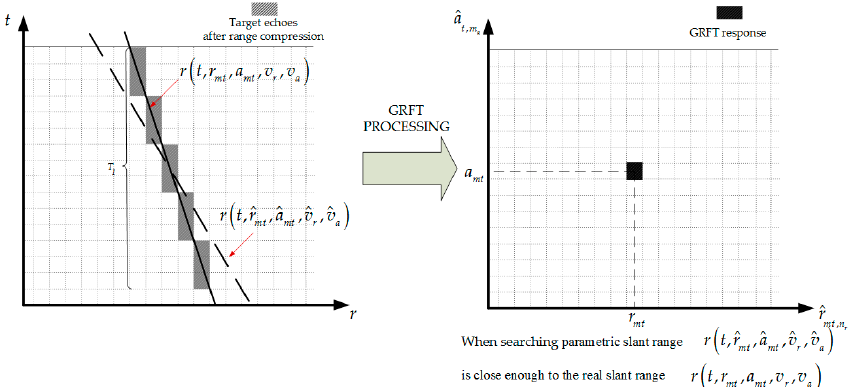
Figure 3. The schematic diagram of generalized Radon-Fourier transform (GRFT)-based signal integration. The GRFT-based signal integration processing for moving ship targets is given, as follows: (1) Determine range-azimuth 2D position and radial-azimuth 2D velocity searching grid according to